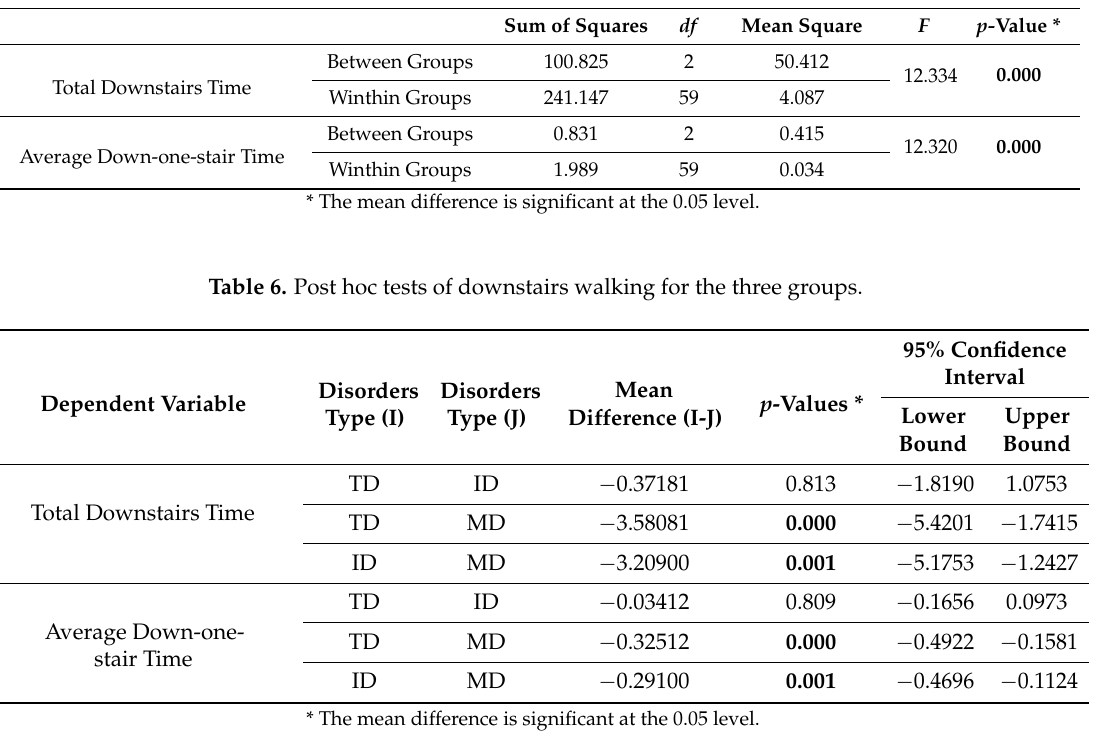
Table 5. ANOVA test of downstairs walking for the three groups.